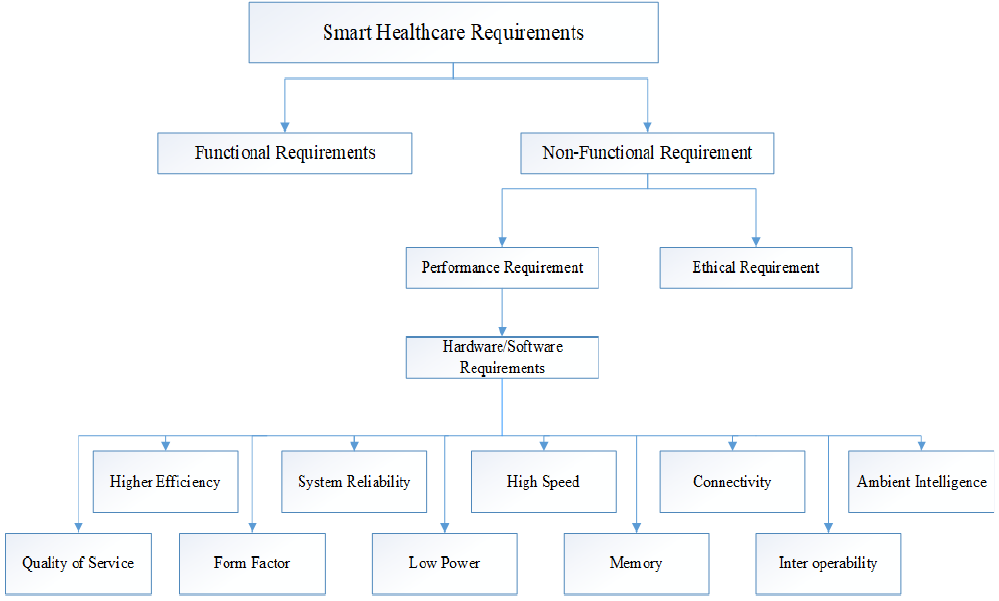
Figure 3. Smart health-care